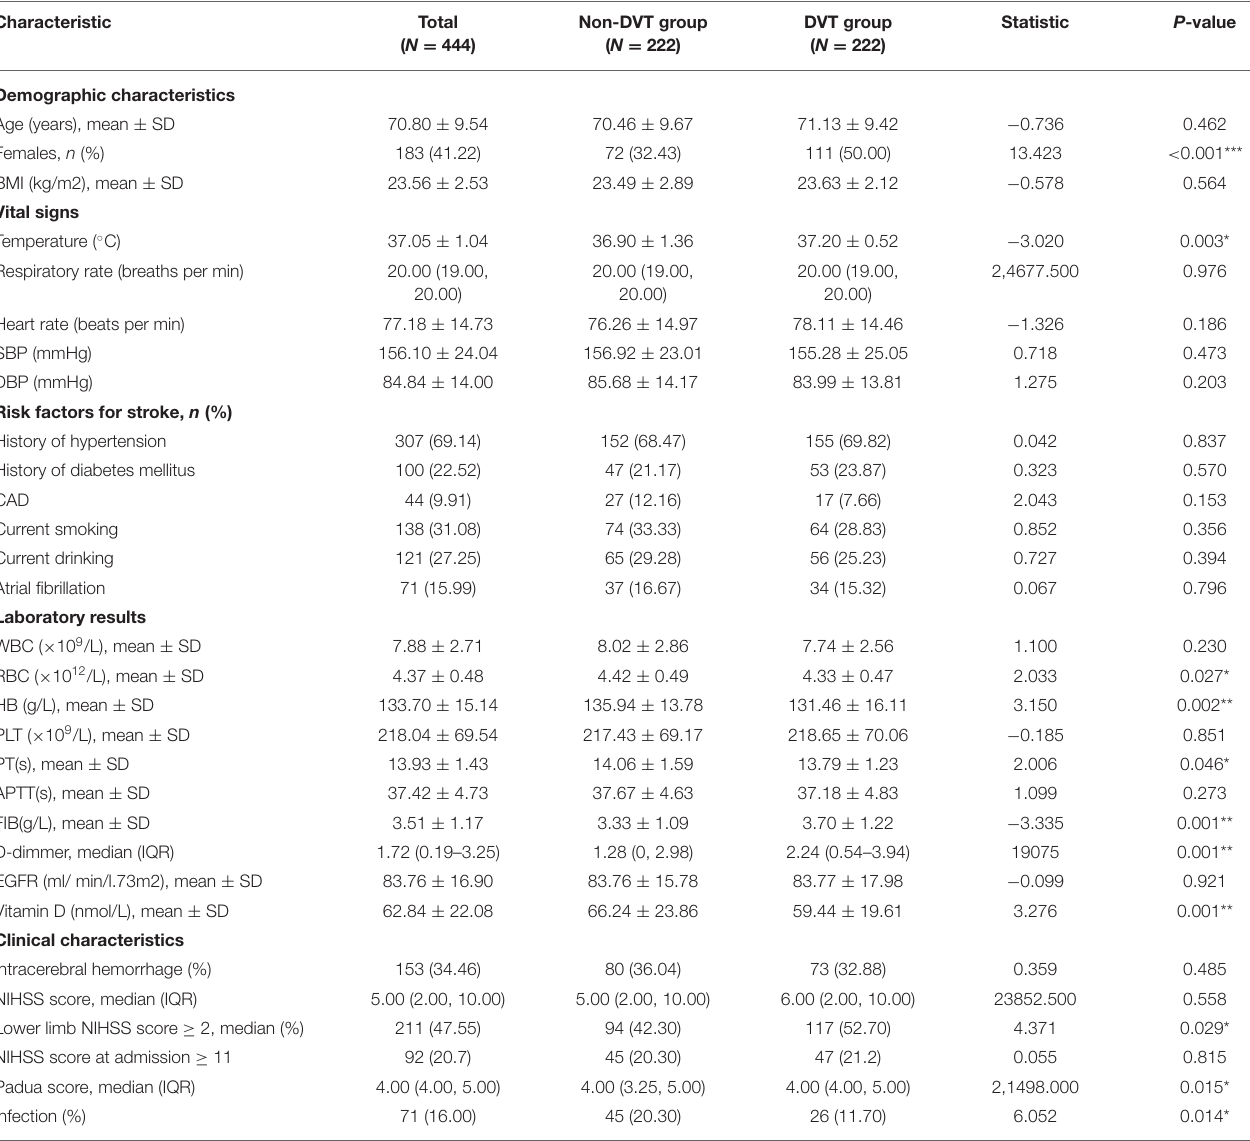
TABLE 1 | Characteristics of all stroke